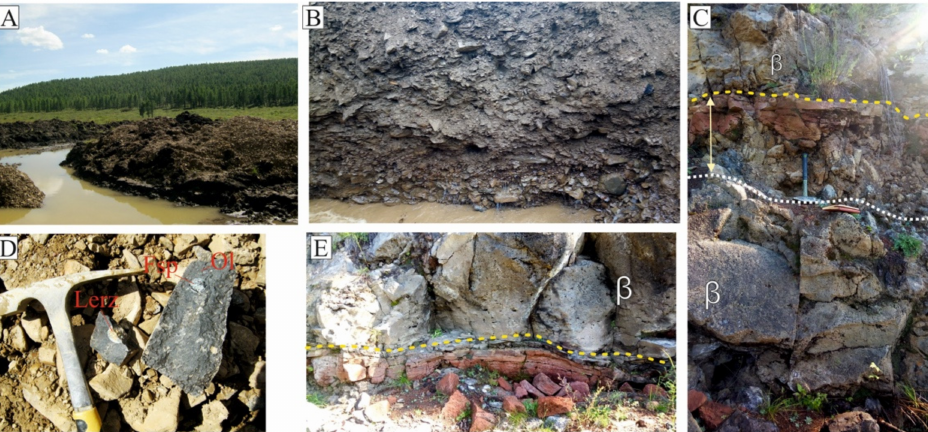
Figure 2. Trenches and test pits in the Naryn-Gol Creek placer. ( A )—exposed permafrost layer; ( B )—gem-bearing bed; ( C )—residual weathered layer and pyroclastic rocks covered by basaltic flows; ( D )—poorly rounded basaltic corestone containing lherzholite xenoliths and megacrysts of olivine and sanidine; and ( E )—basalt flow overlying the residual weathered layer exposed at the base of the Cenozoic volcano. β –basalts; Lerz: lherzolite; Fsp: feldspar; Ol: olivine.